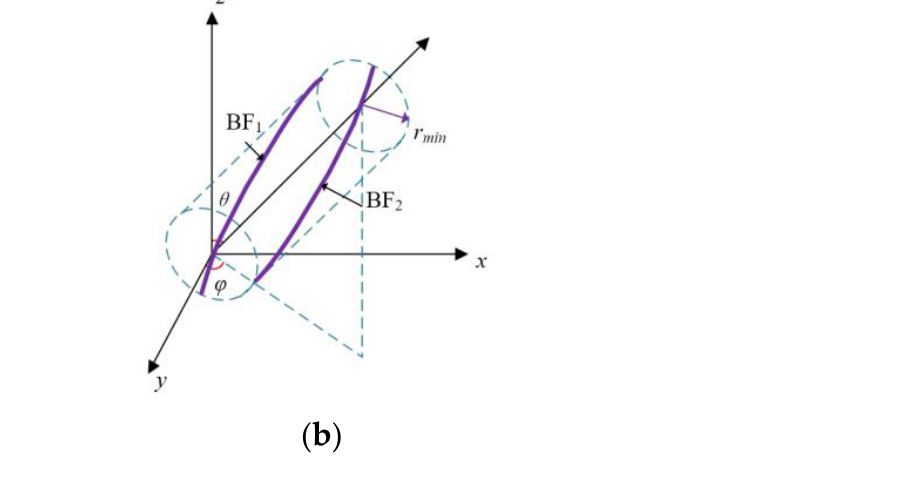
where H l is three components in the HSV color system, f i is the number of pixels with color value i of each component, and N is the total number of pixels in the local block of the image. The BF distribution position in the image is marked by the kernel function: